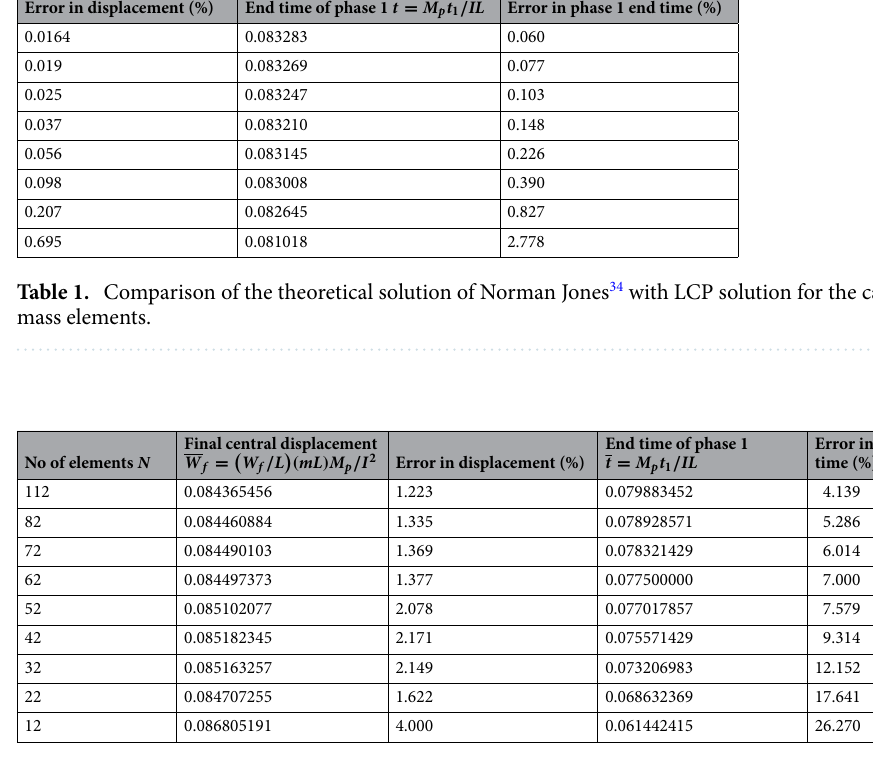
Table 2. Comparison of theoretical solution of Norman Jones 34 with LCP solution for the case of uniform- mass elements.